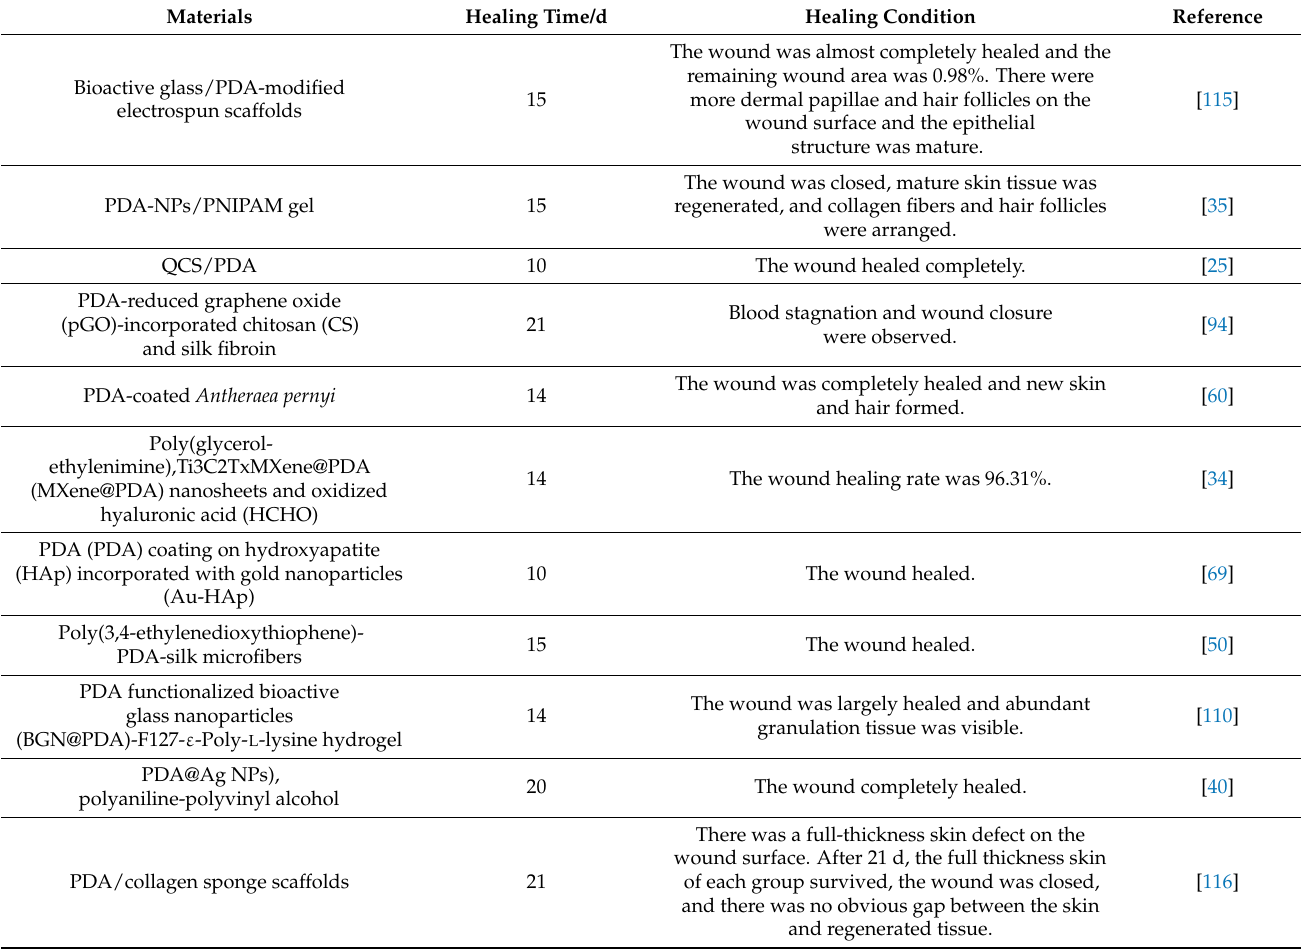
Table 2. Wound healing time and healing status of various PDA compound